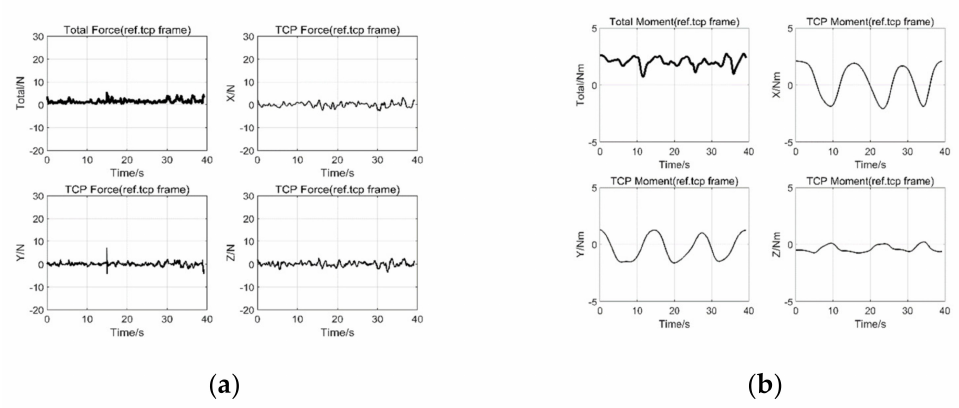
Figure 18. The interaction force and moment between the handle and the subject’s hand. ( a ) is the interaction force between the handle and subject’s hand; ( b ) is the moment between the handle and subject’s